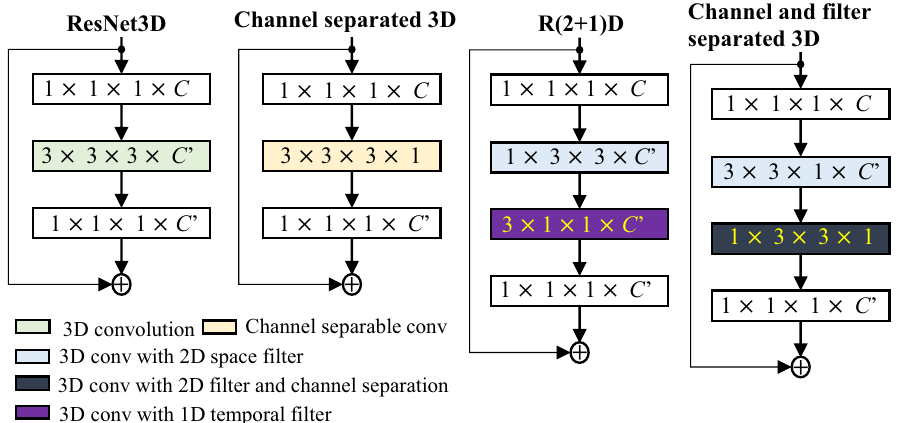
Figure 2. 3D convolution and its variants in residual block representation.